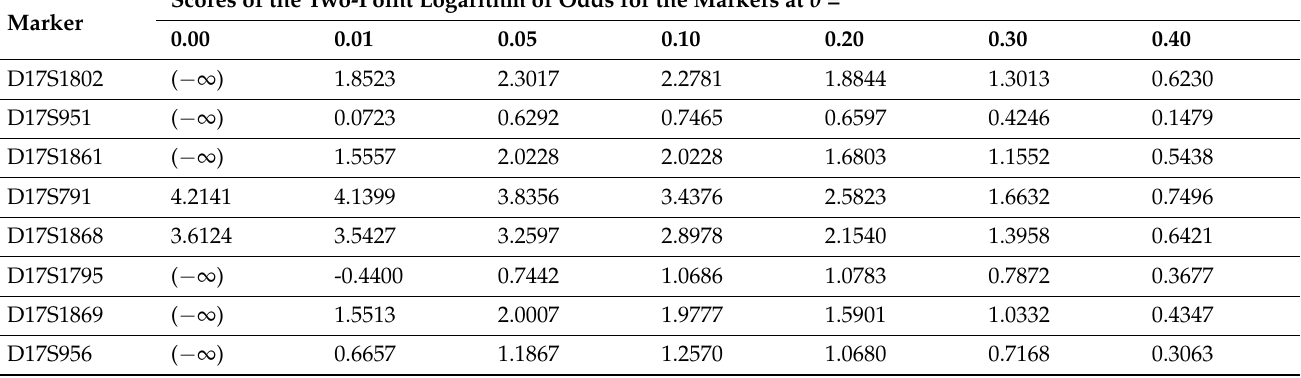
Table 2. Scores of the 2-point logarithm of odds for the eight markers on chromosome 17q21.31-q21.33 at distinct recombination fractions in Family 1 suffering congenital heart